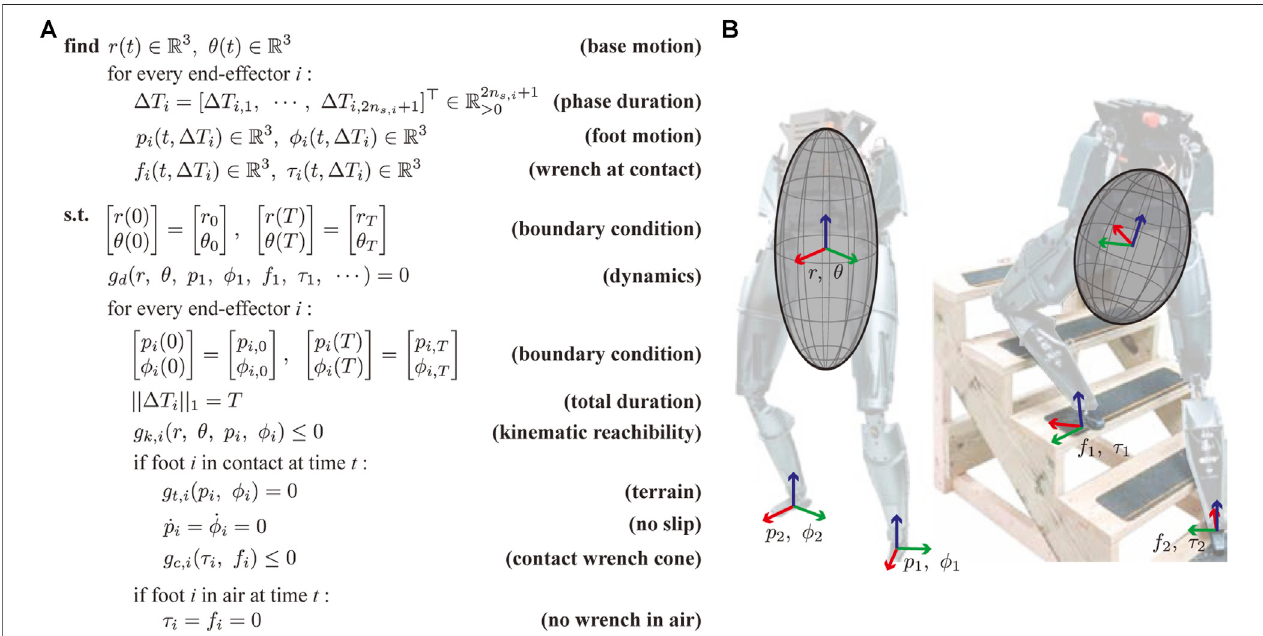
FIGURE 2 | (A) The TOWR+ locomotion planning algorithm is presented. (B) Illustrative examples of the CRB model are shown for two different biped robot con fi gurations. The con fi guration dependent centroidal inertias of the robot are depicted as